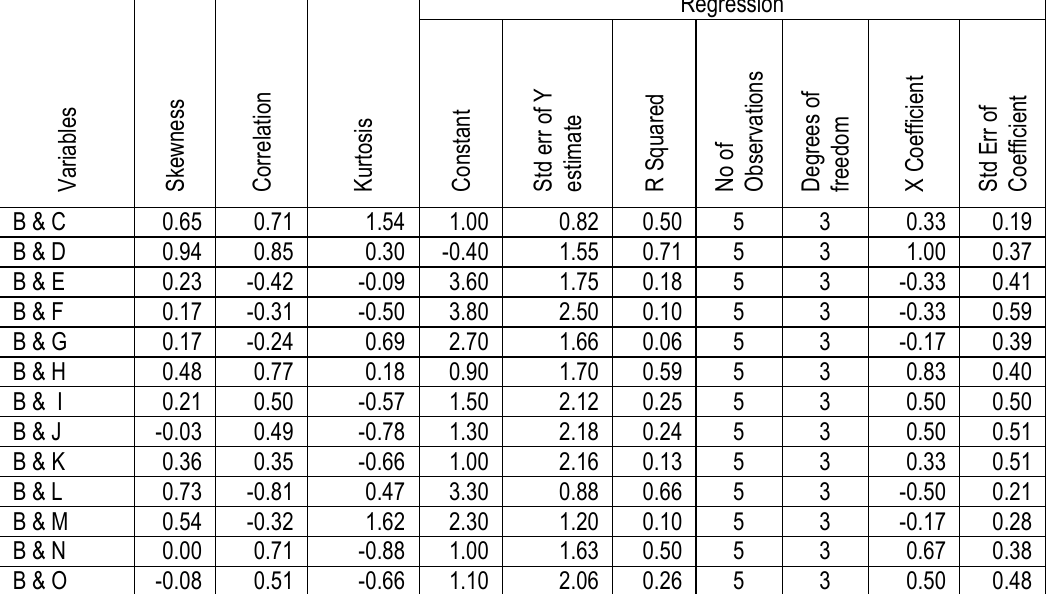
Table 3. Relationship of Student Support with other Variables